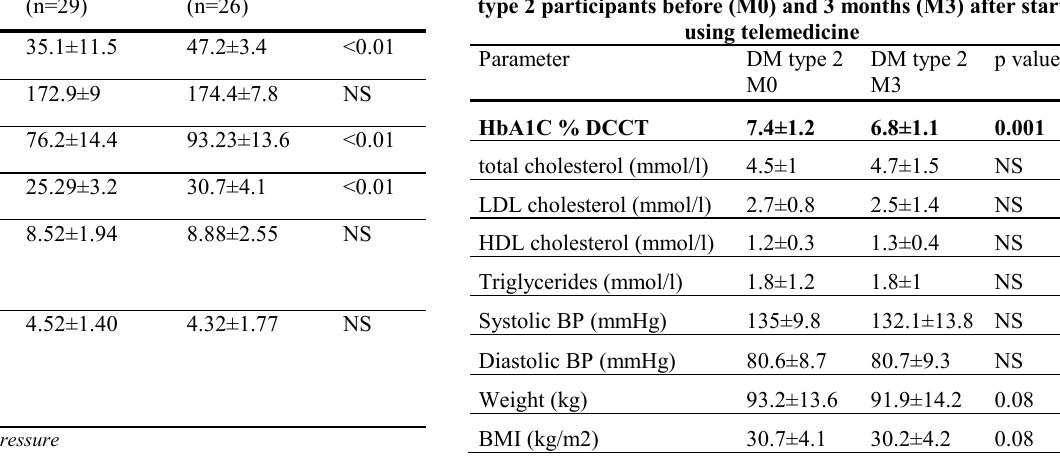
Table 3. Description of characteristics (mean ± SD) in